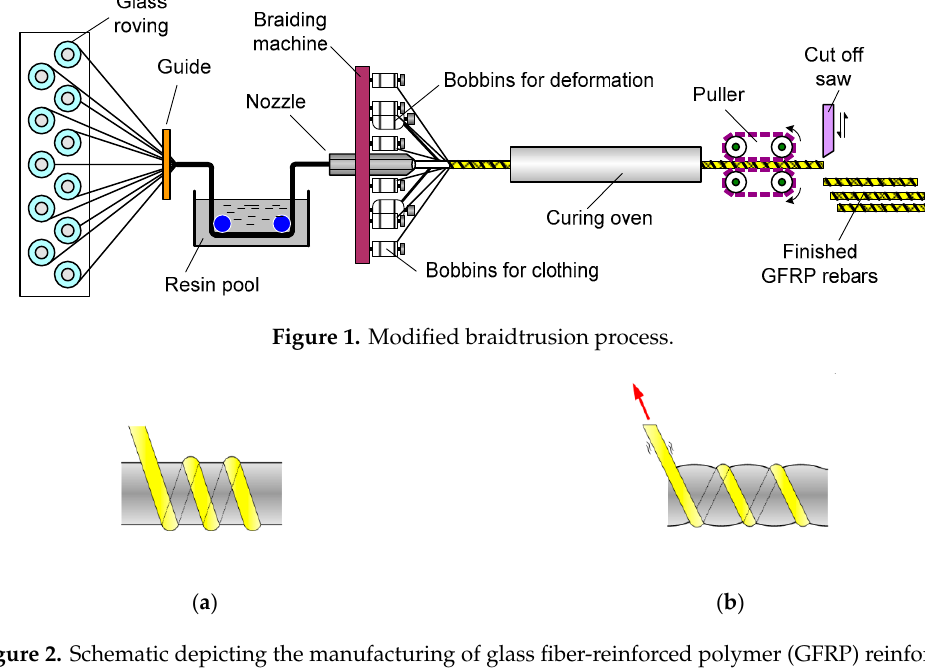
Figure 2. Schematic depicting the manufacturing of glass fiber-reinforced polymer (GFRP) reinforcing bars (rebars). ( a ) general braiding. ( b ) modified braiding.